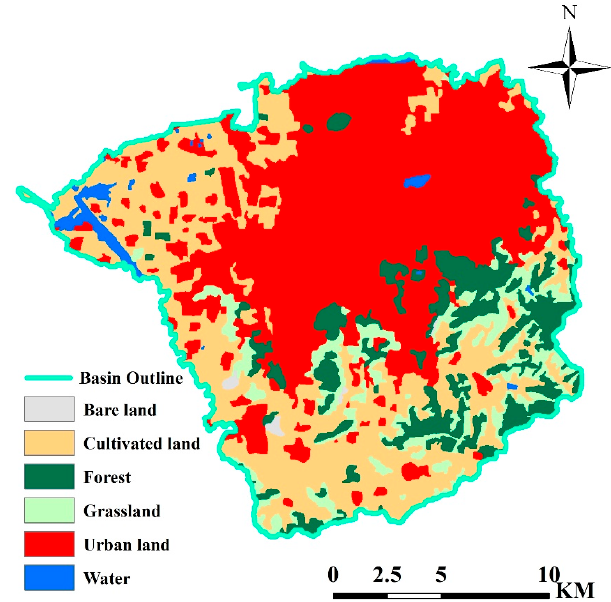
Figure 1. Map of the Huangtaiqiao basin .